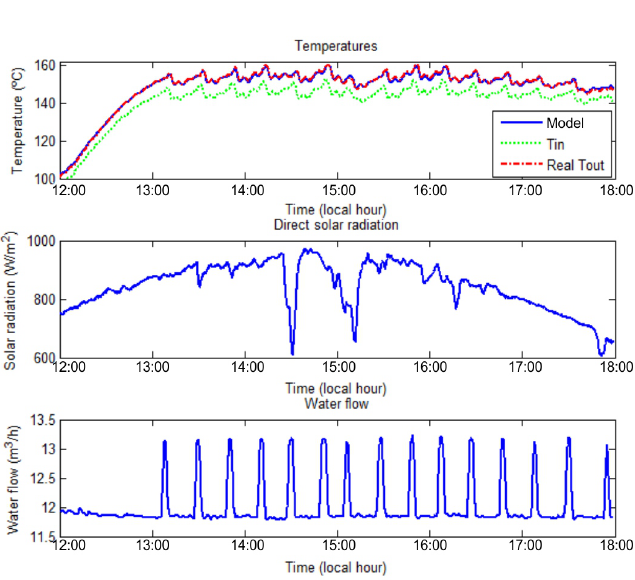
Figure 5. Solar field evolution model vs. real: 29 June